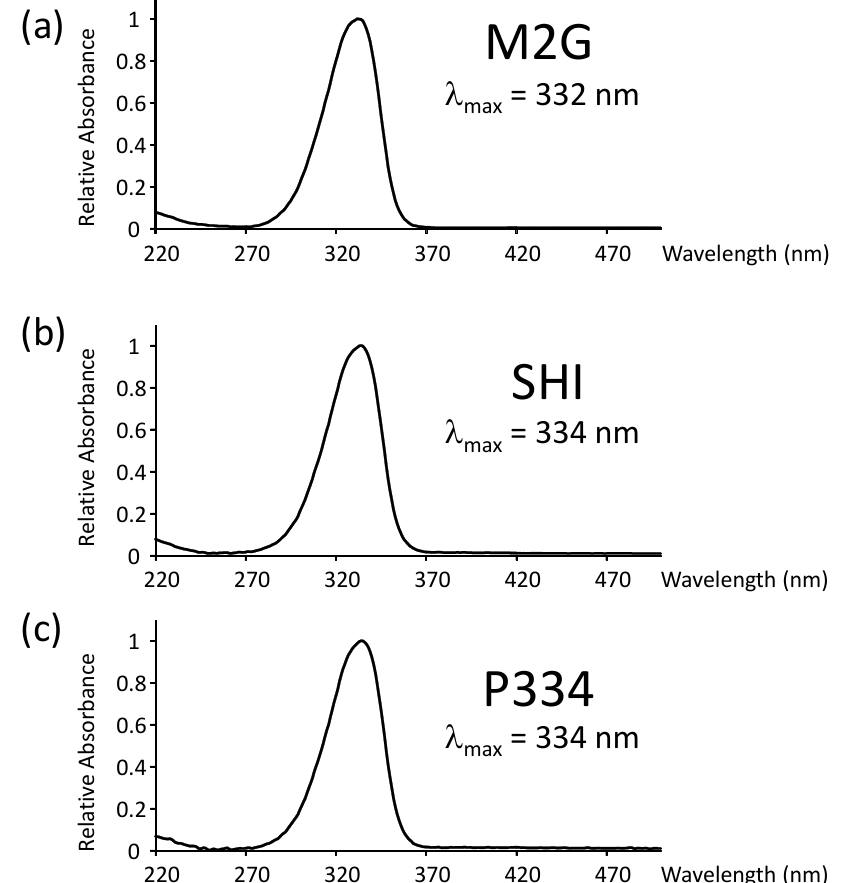
Figure 2. Absorption spectra of ( a ) mycosporine-2-glycine (M2G), ( b ) shinorine (SHI), and ( c ) porphyra-334 (P334).